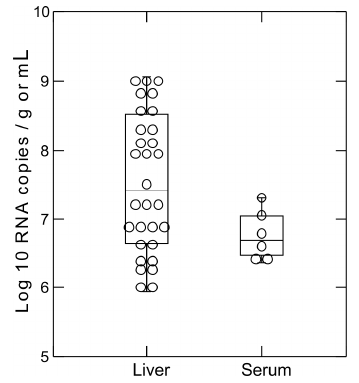
Figure 1. Box plot of rodent hepacivirus RNA concentration with each dot representing one sample.